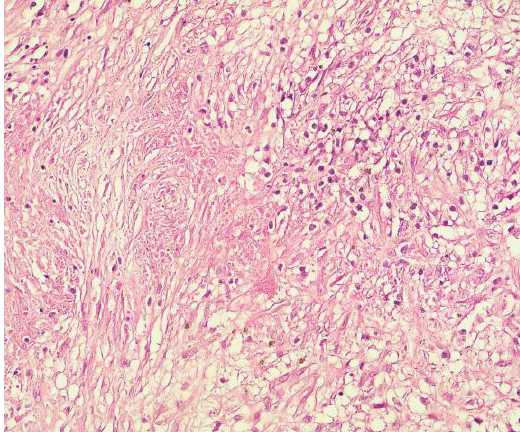
Figure 3. Clear cell proliferation with association of focal areas of intralesional necrosis (H and E, ×40).